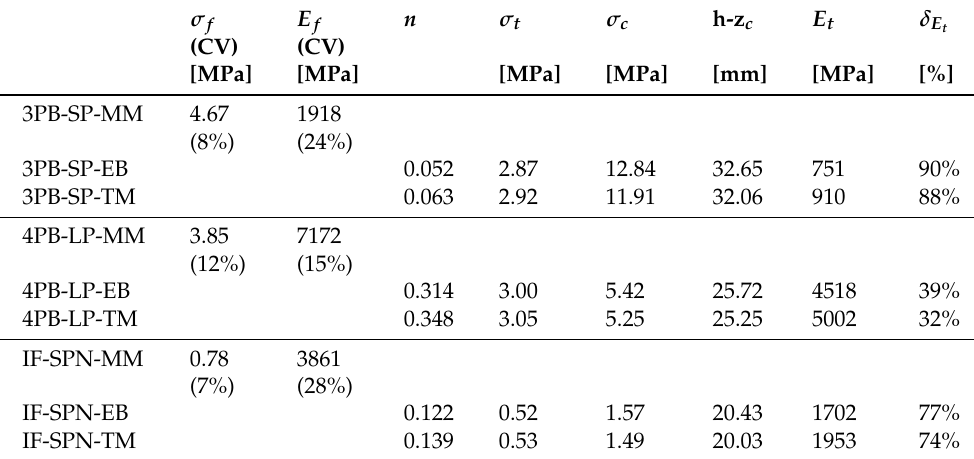
Table 9. Results of the mono-modulus (MM) and bi-modulus model (EB for Euler–Bernoulli and TM for Timoshenko beam model) applied to three-point (3PB-SP and IF-SPN) and four-point (4PB- LP) bending tests employing the average values of the vertical displacements η exp of each bending test. The flexural stress value σ f , the flexural elastic modulus E f , the moduli ratio coefficient n , the maximum values of the tensile and compressive stress σ t σ c , the position of the neutral axis h-z c , the elastic modulus in tension E t and the percentage difference between the evaluated E t and the experimental value of modulus in tension (7422 MPa) δ E are reported for each bending t